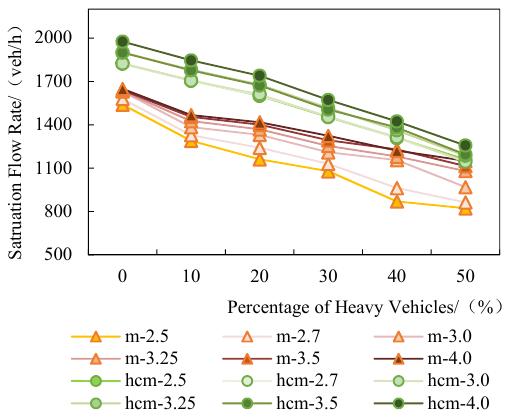
Figure 8. Comparison between estimated saturation flow rates (by the Highway Capacity Manual (HCM) method) and measured saturation flow rates.